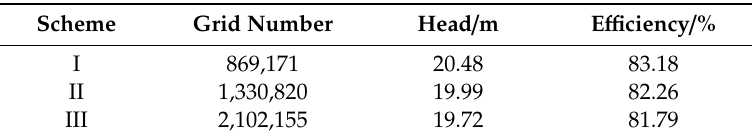
Table 3. Grid Independence